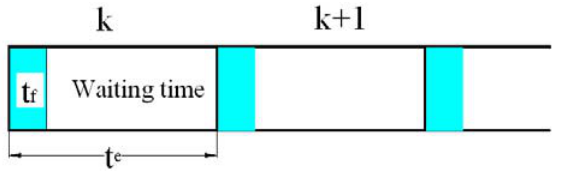
Figure 3. Proportion of time used for filtering in integrated navigation system. t is time required for filtering. of each epoch k , and t f